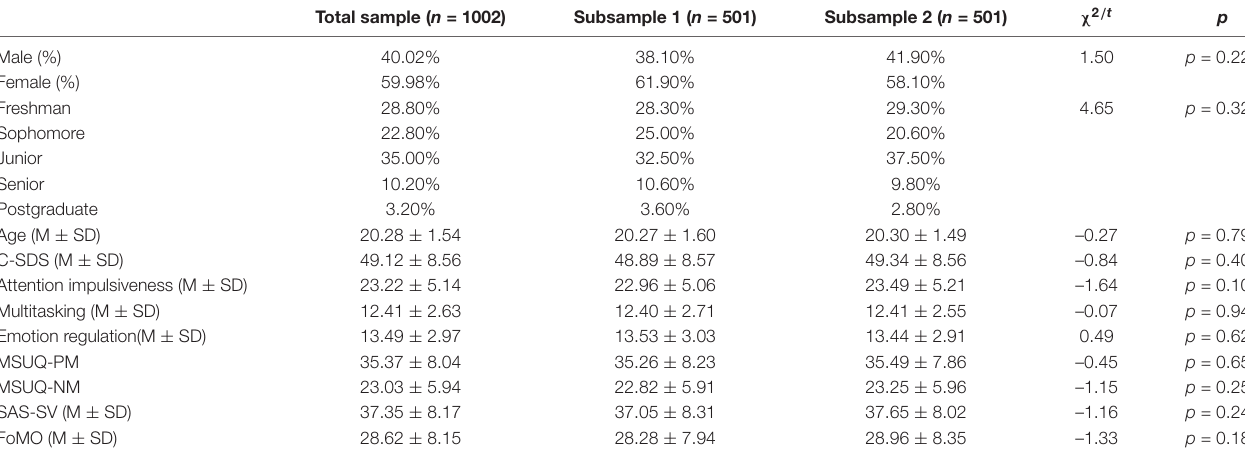
TABLE 1 | Comparison between the two